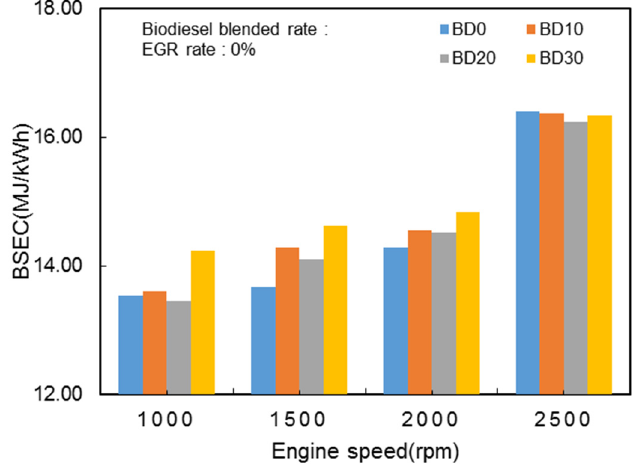
Figure 5. Effects of the biodiesel blend ratio and engine speed on the brake specific energy consumption